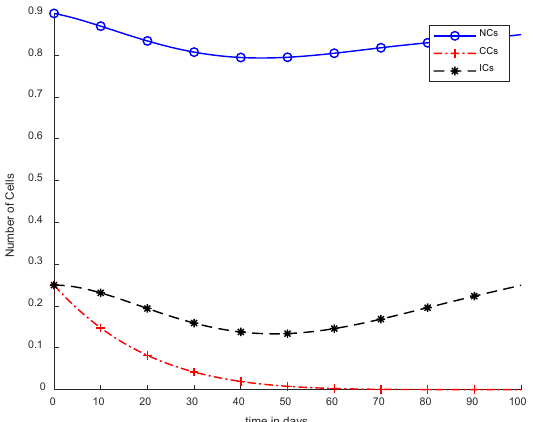
Figure 7. With chemotherapy constant dose and SMC for CCs Killer. Moreover, in Figure 8, case-4b represents that CCs reduced in about sixty days. Due to the speedy behavior of chemotherapy, CCs and NCs reached the very minimum threshold, which is quite dangerous for the body. In case-5a, whose results are shown in Figure 9, the contemporary SC was applied with chemotherapy at a constant dose. Optimal results were obtained in which NCs and ICs were at maximum level. However, CCs were reduced to level zero within five days. Figure 10 is the result of case-5b, which depicts that using SC, CCs were removed during five days with continuous chemotherapy.